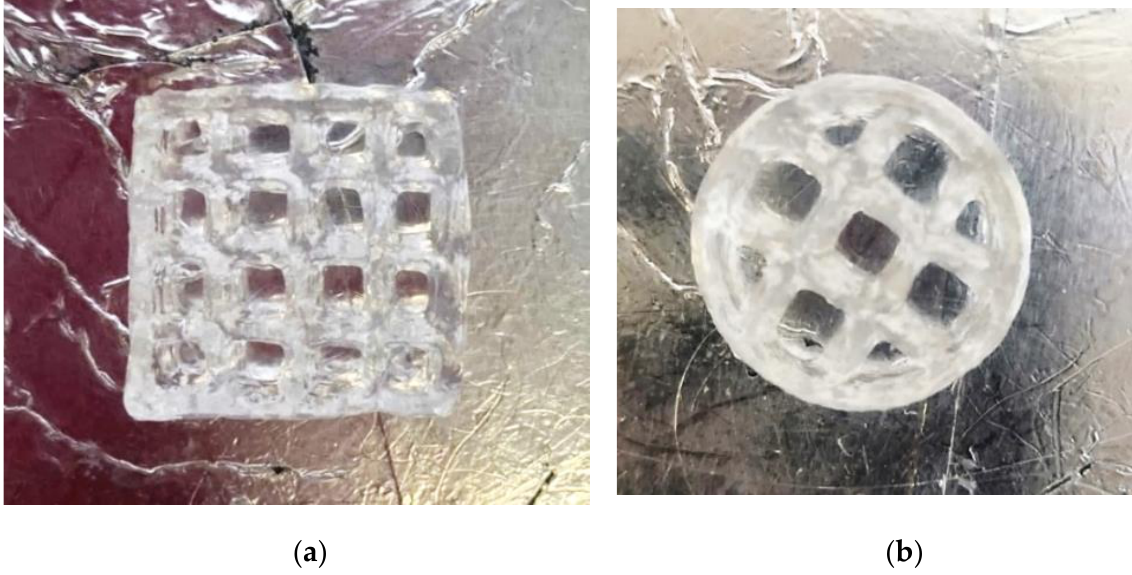
Figure 6. Pictures of gel printed objects. ( a ) Printed lattice in a parallelepiped, ( b ) printed lattice in a cylinder. The resulting models have the following geometric dimensions: wall length (Figure 6a) and diameter (Figure 6b)—10 mm; height—5 mm; wall thickness—1